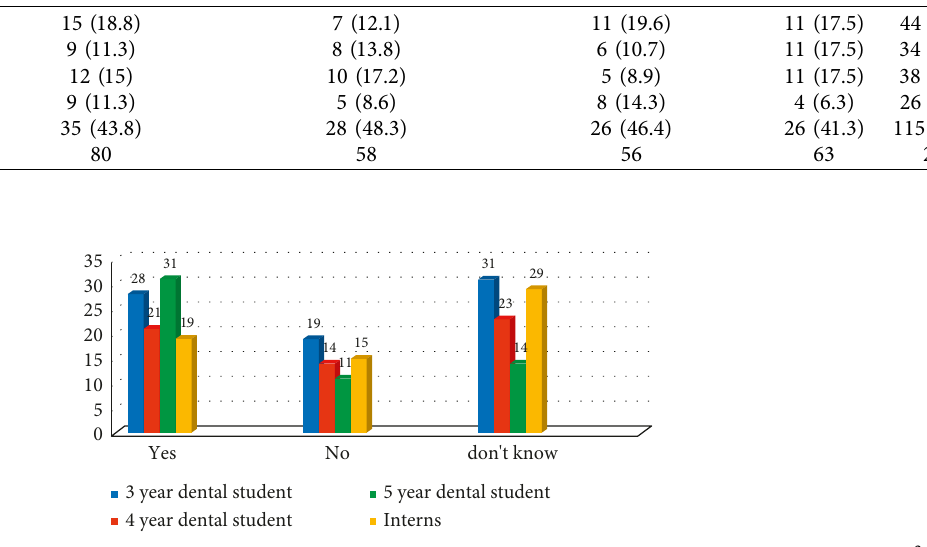
Figure 5: Awareness of participants toward digital radiography compared to conventional radiography in exposure difference ( χ 2 with P 0 . 148). >